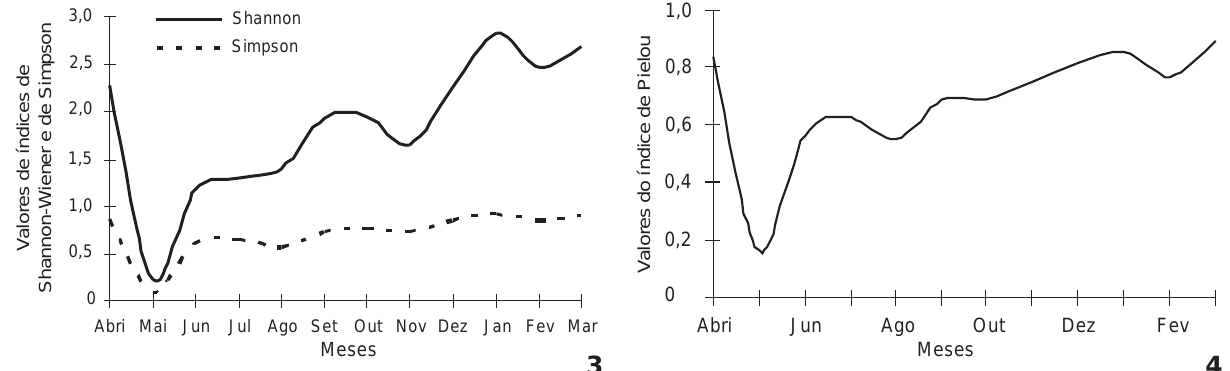
Figuras 3-4. Variação média mensal dos índices de diversidade de Shannon-Wiener e Simpson (3) e do índice de equitabilidade de Pielou (4), durante o período de 2006 a 2007, em São Bento do Sul.